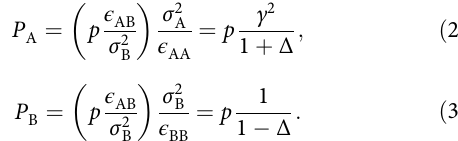
(1 + Δ ) and 1 + Δ , respectively. Correspondingly, Eq. (5) shows that T m,B ( p ) can be obtained by multiplying the pressure and temperature of T m ( p ) curve by 1 − Δ and 1 − Δ , respectively.